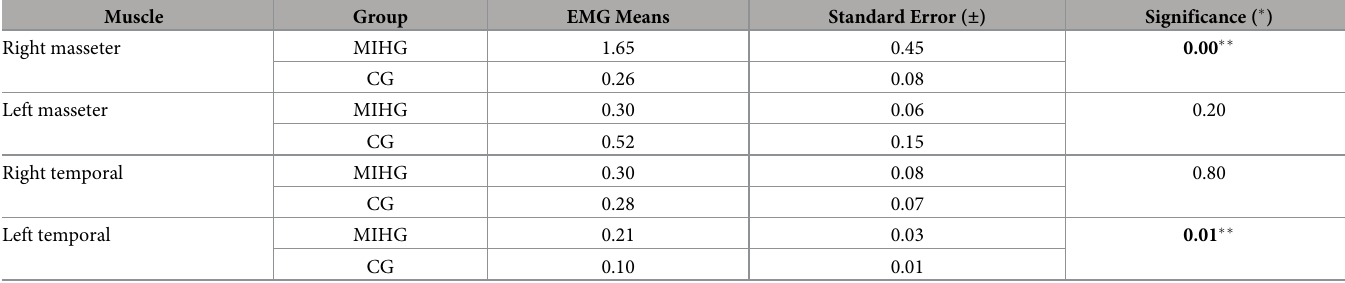
Table 5. Mean values, standard error, and statistical significance (p � 0.05) of the normalized electromyographic data in the right laterality condition, for each muscle evaluated, in the MIH group (MIHG) and control group (CG). Muscle